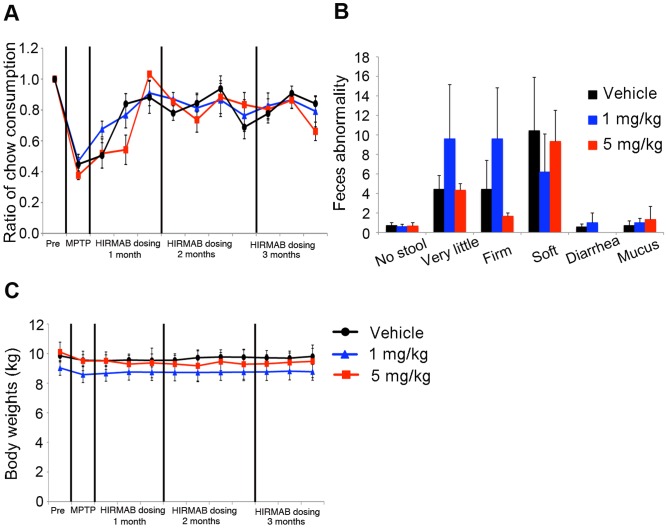
HIRmAb-GDNF treatment did not affect food consumption, feces output, or body weight.(A) Ratio of food consumption overtime (average per week after treatment/average at baseline) (B) Frequency of abnormal feces. (C) Body weight over time.